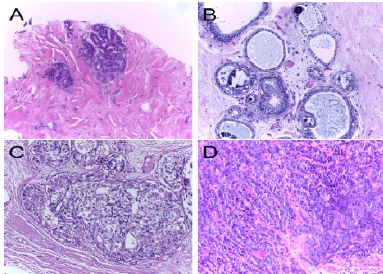
Figure 5. Examples of H&E stained images from the ICIAR2018: ( A ) normal tissue; ( B ) benign lesion; ( C ) in situ carcinoma; ( D ) invasive carcinoma. Hematoxylin stains the nuclei purple while eosin stains the stroma pink [34].